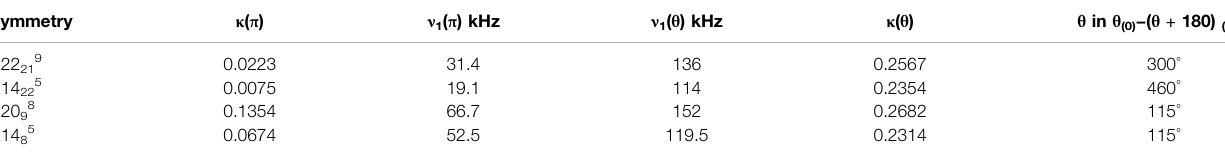
TABLE 2 | Scaling factor and match conditions for Selected Symmetry sequences.